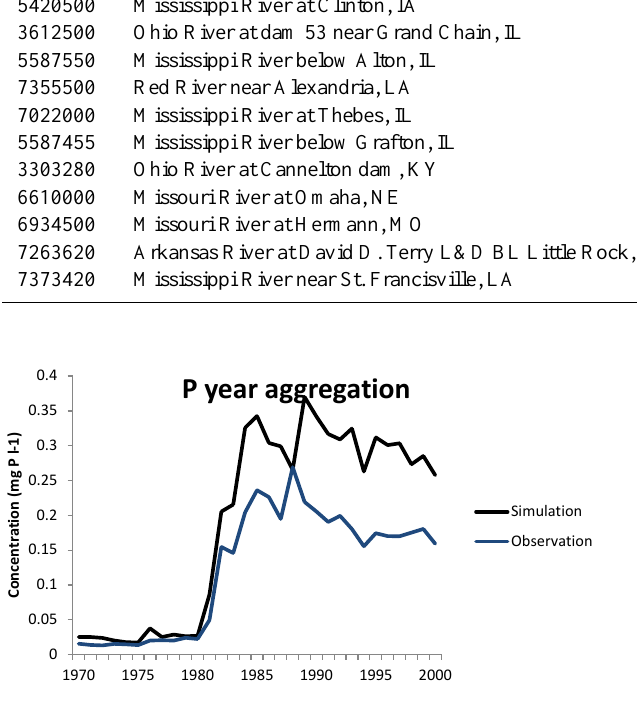
Figure 10. Comparison of simulated total N concentrations for the year 1990 with the validation data set for the early 1990s for total N collected by Van Drecht et al. (2003) with a 1:1